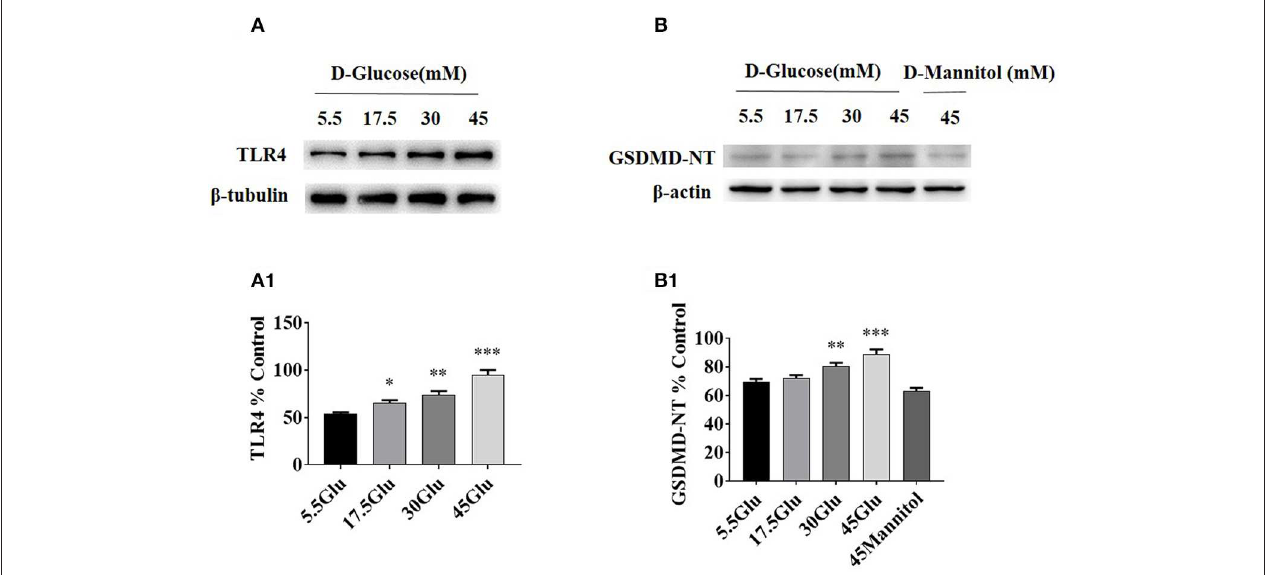
FIGURE 3 | TLR4/ NF- κ B and GSDMD-NT expressions were increased in HK-2 cells under HG condition. (A) WB and densitometric analysis of TLR4 in HK-2 cells exposed to different concentrations of D-glucose. (B) Protein expression of GSDMD-NT exposed to different concentrations of D-glucose. The protein level of TLR4 (A1) and GSDMD-NT(B1) in HK-2 cells exposured to D-glucose (5.5, 17.5, 30, and 45mM) for 24h. Each assay was representative of three independent experiments. Data were expressed as means ± SEM. (* P < 0.05 vs. control; ** P < 0.05 vs. 17.5Glu group; *** P < 0.05 vs. 30Glu group).